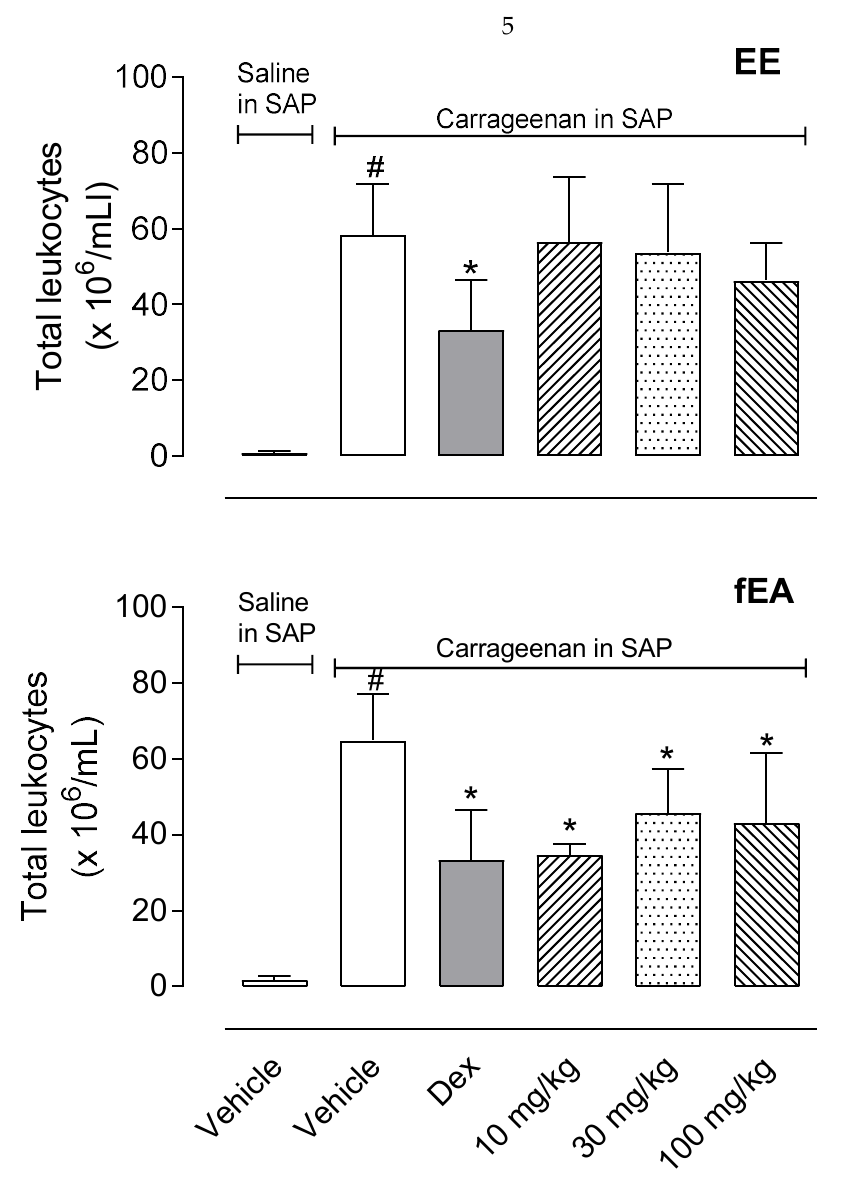
Figure 4. Effect of the ethanol extract (EE) and fraction in ethyl acetate (fEA) from leaves of T. granulosa in leukocyte migration into the subcutaneous air pouch. The animals were pre-treated with vehicle, dexamethasone (Dex, 0.5 mg/kg, i.p.), EE or fEA (10, 30, or 100 mg/kg), 60 min before the injection of carrageenan (1%) or saline in the SAP. The results are presented as mean ± S.D. ( n = 7). The statistical significance was calculated comparing the groups pre-treated with EE, fEA, or dexamethasone with the group pre-treated with the vehicle, using ANOVA followed by the post-test of Newman–Keuls. # p < 0.05 when comparing the vehicle-treated group receiving carrageenan in SAP with the vehicle-treated group that received saline in SAP; * p < 0.05 when comparing dex-, EE-, or fEA-treated groups that received carrageenan in SAP with the vehicle-treated group receiving carrageenan in SAP.